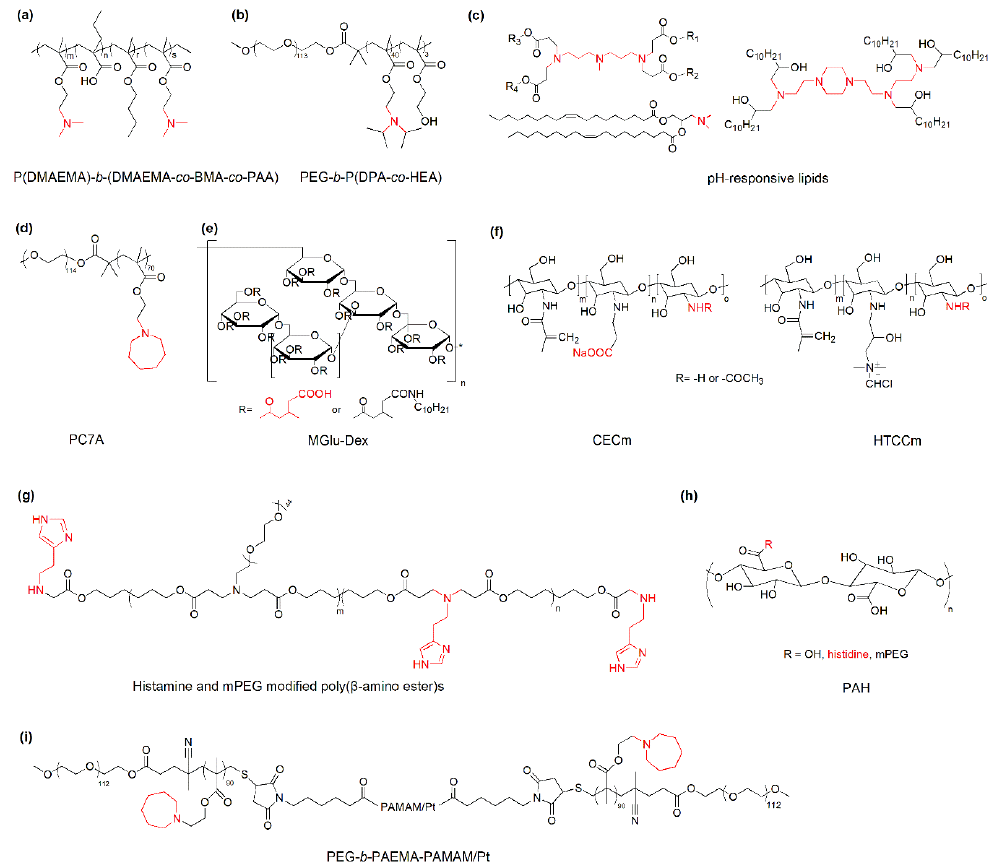
Figure 3. Representative materials with pH-dependent protonation/ionization for cancer immunotherapy.